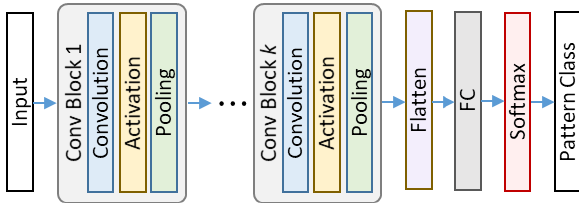
Figure 2. Typical convolutional neural network architecture.